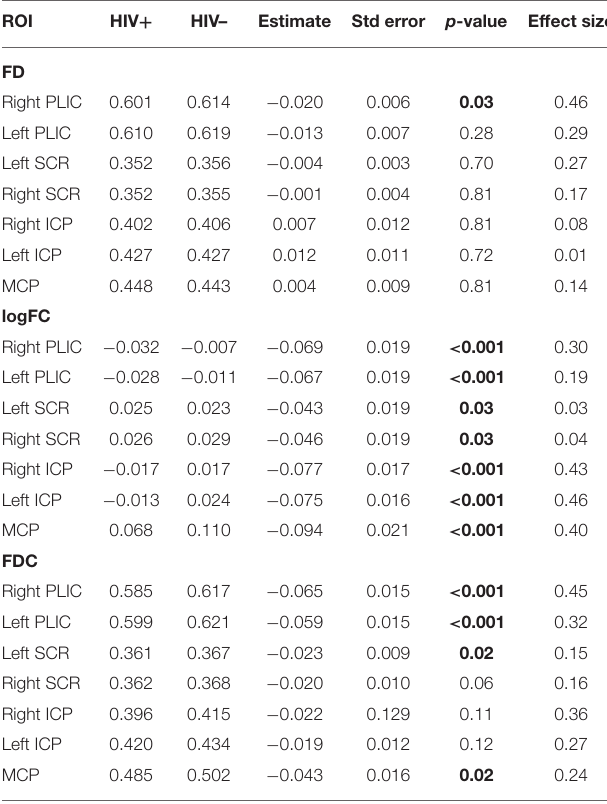
TABLE 2 | Linear regression model comparing the FBA metrics in HIV + and HIV– individuals, with age and sex included as covariates.